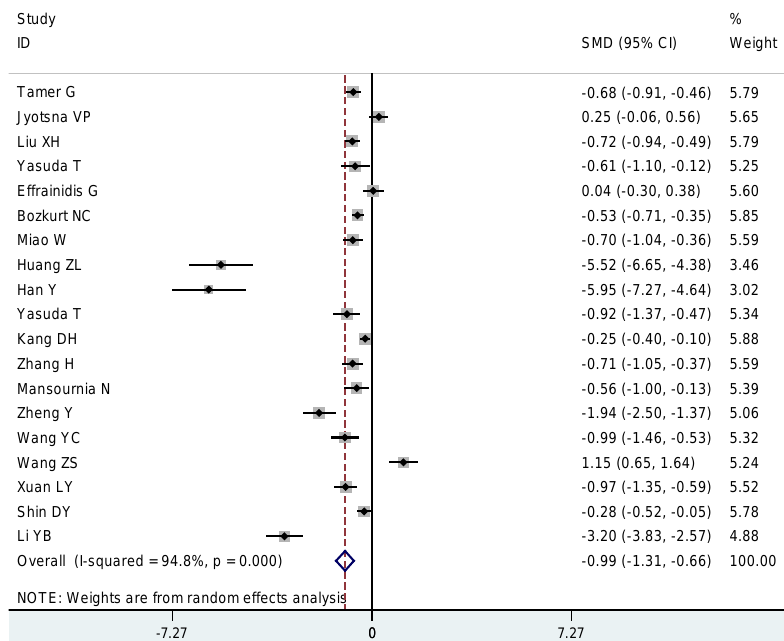
Figure 1. Flow diagram showing study selection.